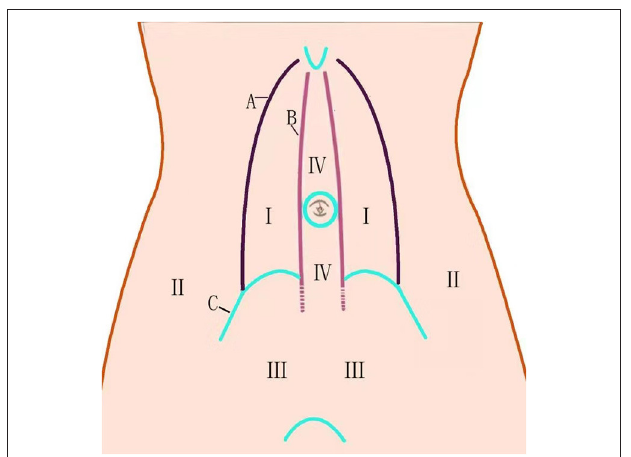
FIGURE 2 | Extraperitoneal space in abdominal wall.